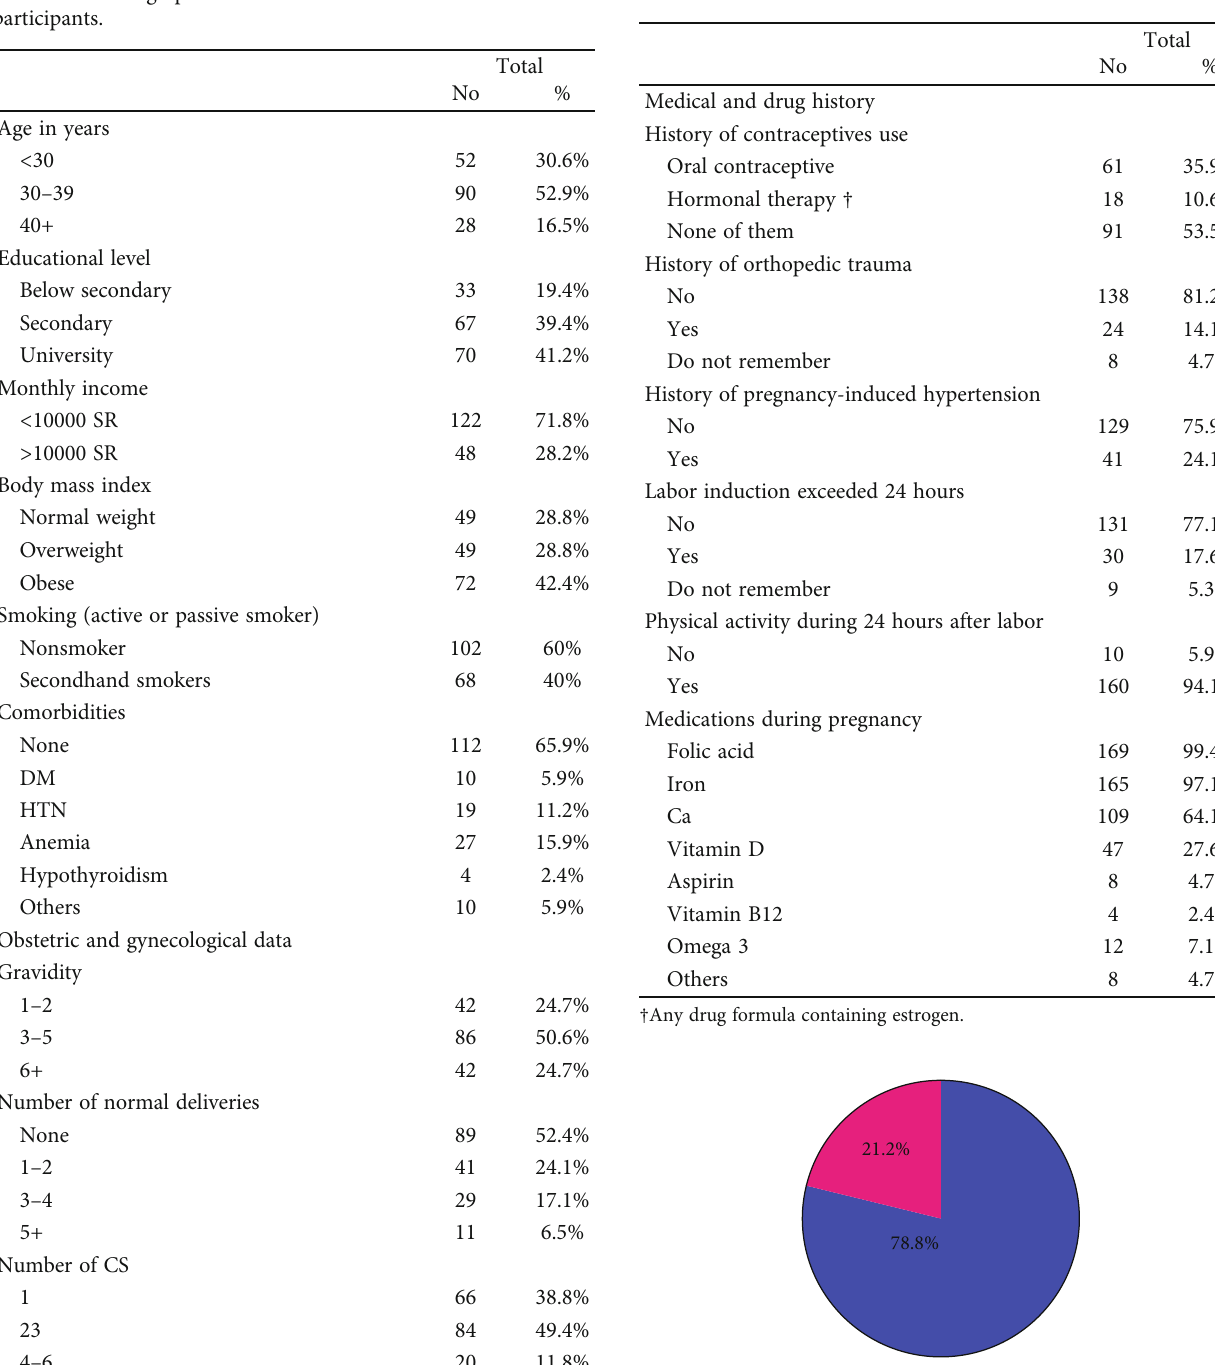
Table 1: Demographic and clinical characteristics of the 170